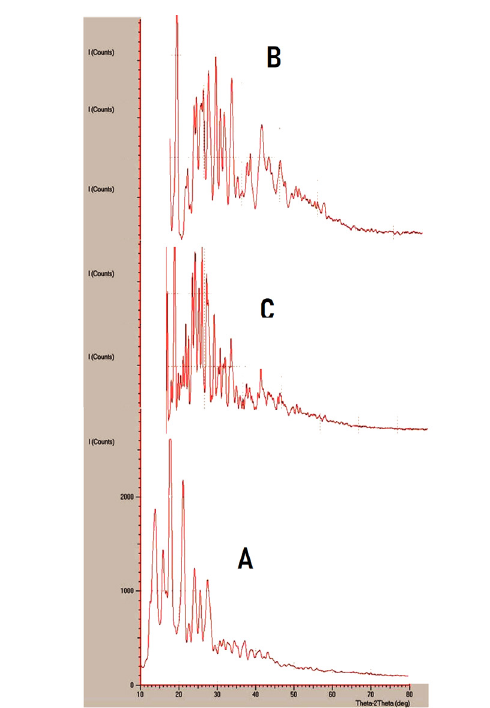
FIGURE 3 - X-RD study of pure drug (A); β-CD (B) and F27 formulation TABLE II - List of factors and response variables selected for response surface optimization